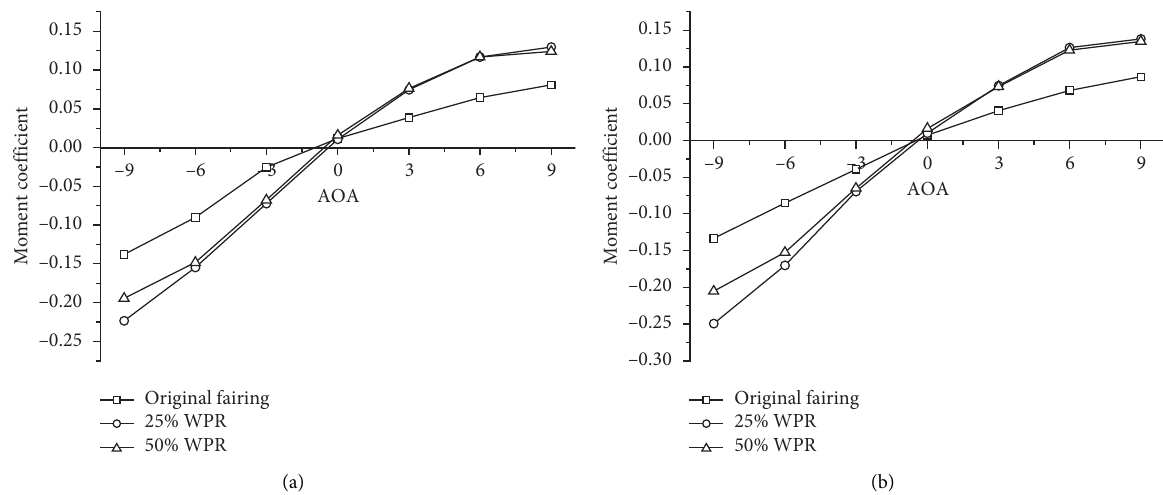
Figure 11: Static wind tunnel test results for C